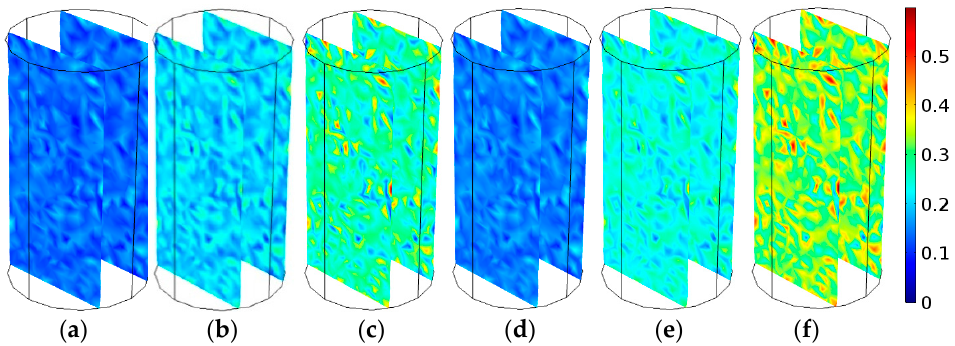
k = 2, pH = 6.6): ( a ) T = 80 w